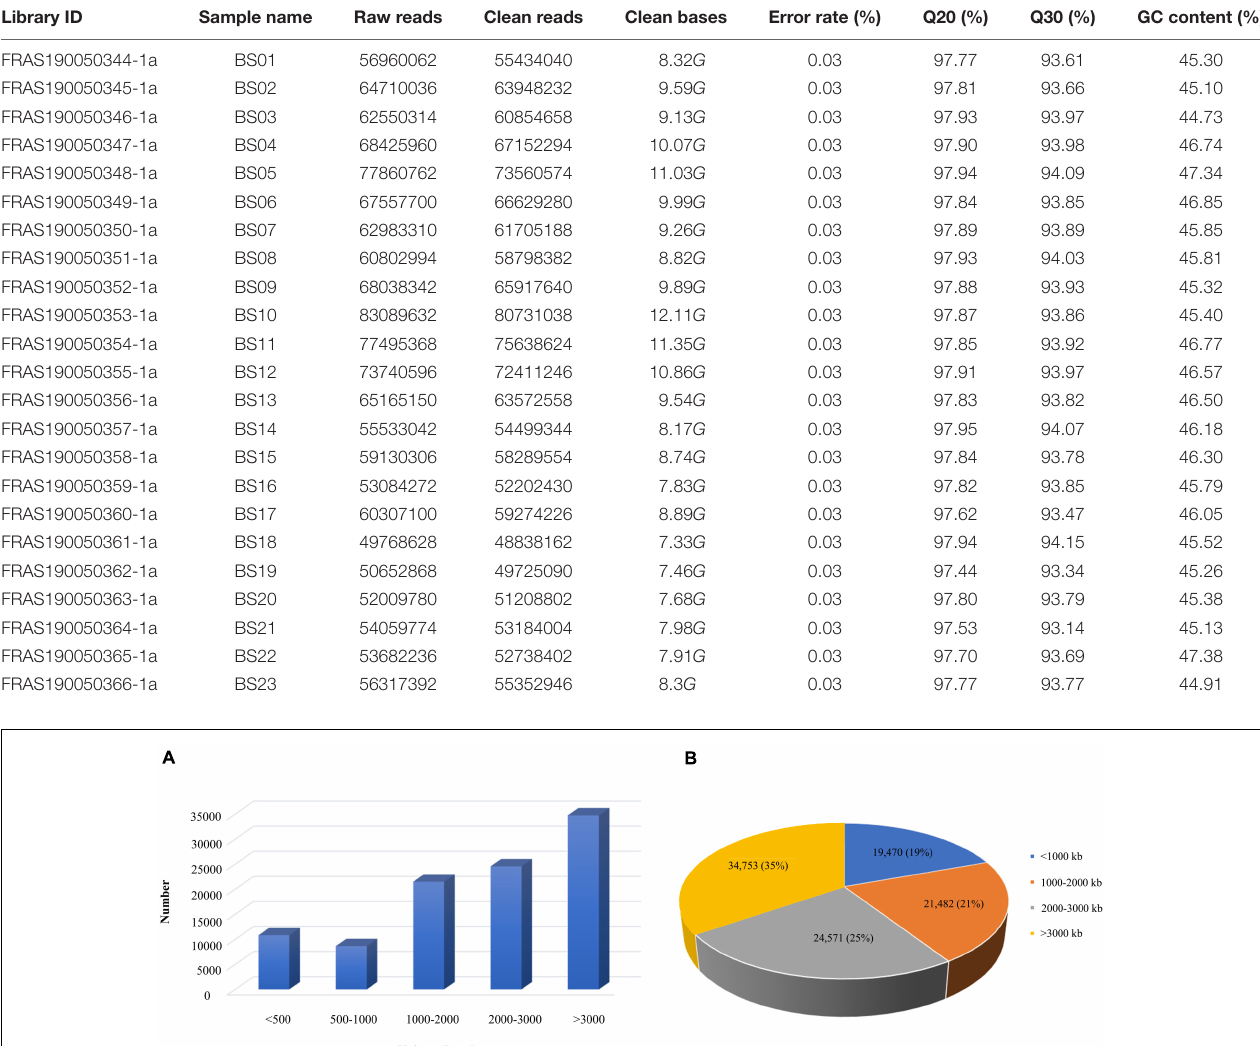
TABLE 1 | Summary of quality of raw sequencing data based on Illumina sequencing.